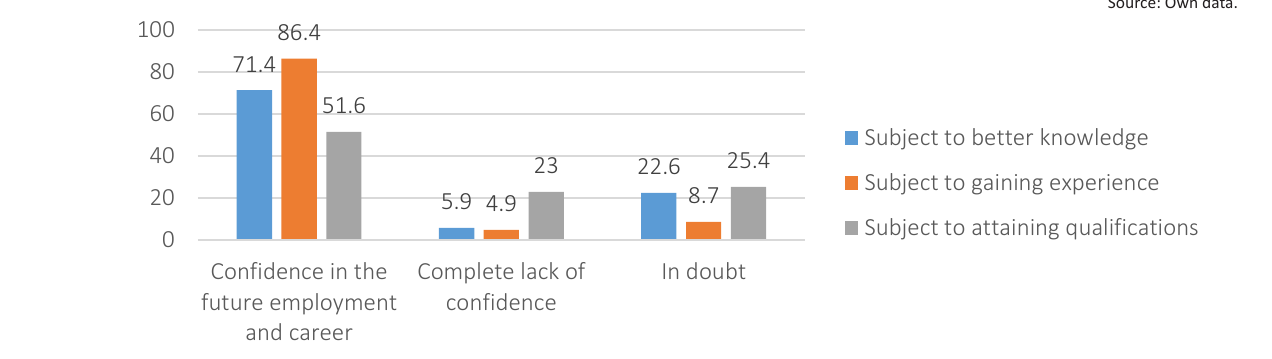
Figure 3. Confidence in the prospects of the personal